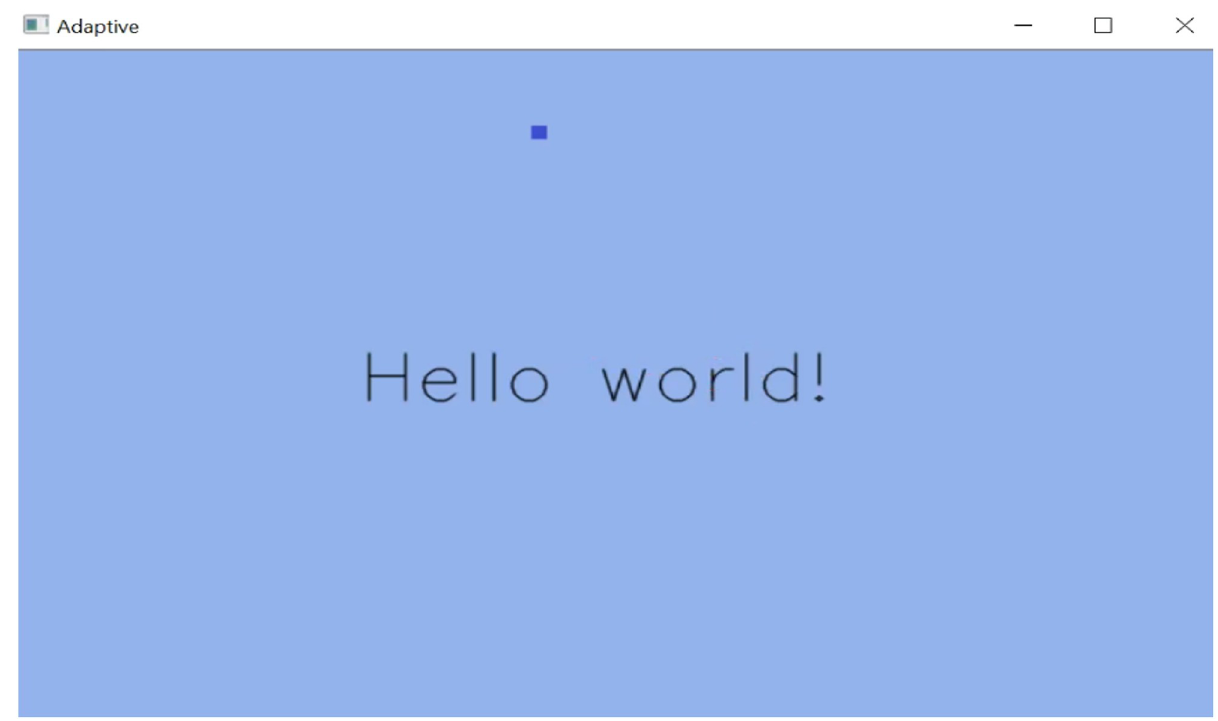
Fig 5. Automatic AUI main